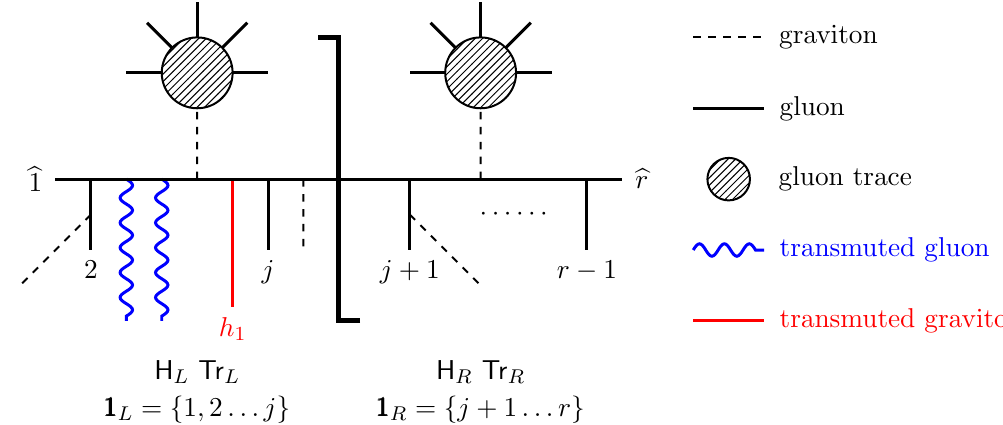
Figure 2 . A typical BCFW factorization channel of (9.6) with h 1 2 H L .